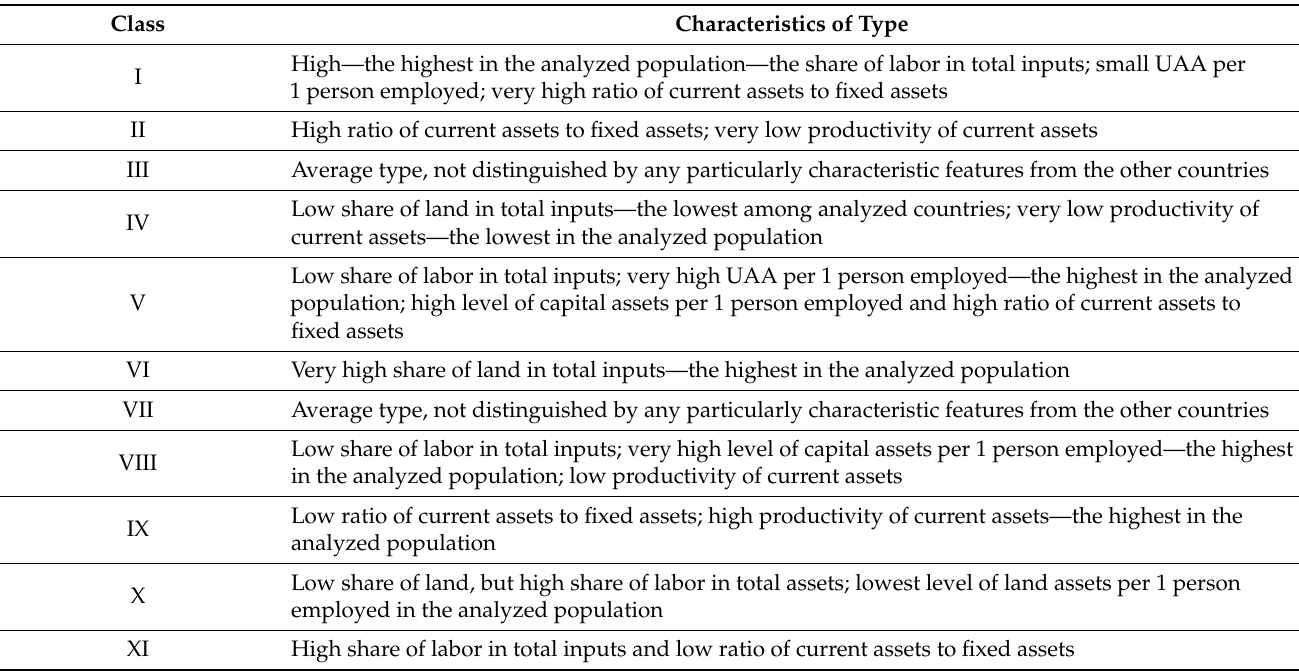
Table 6. Characteristics of types of analyzed countries distinguished based on the production potential of the agricul- tural